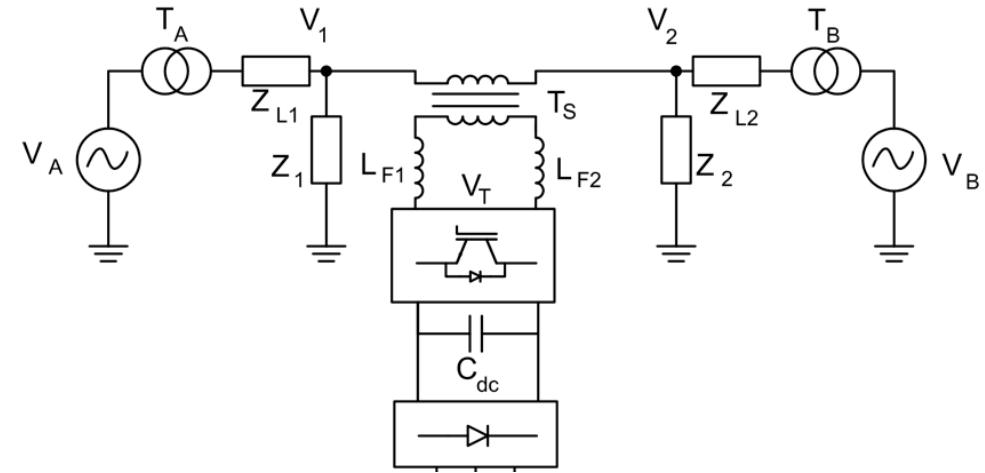
Figure 3. Simplified distribution power system with the series VSC.